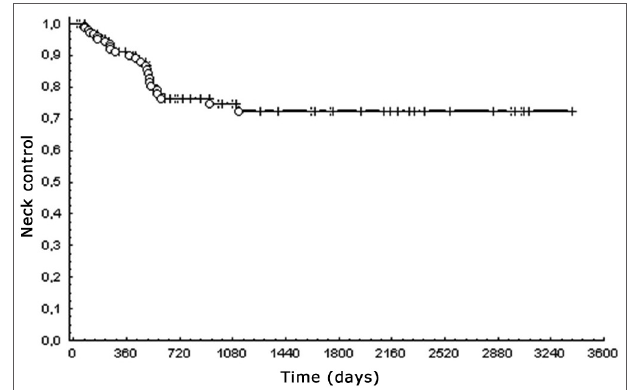
Figure 2. Cervical control in hypopharyngeal squamous cell carcinoma. Table 2. Distribution of histological metastases (pN) in contralateral neck dissection in cervical recurrences of non-operated necks.